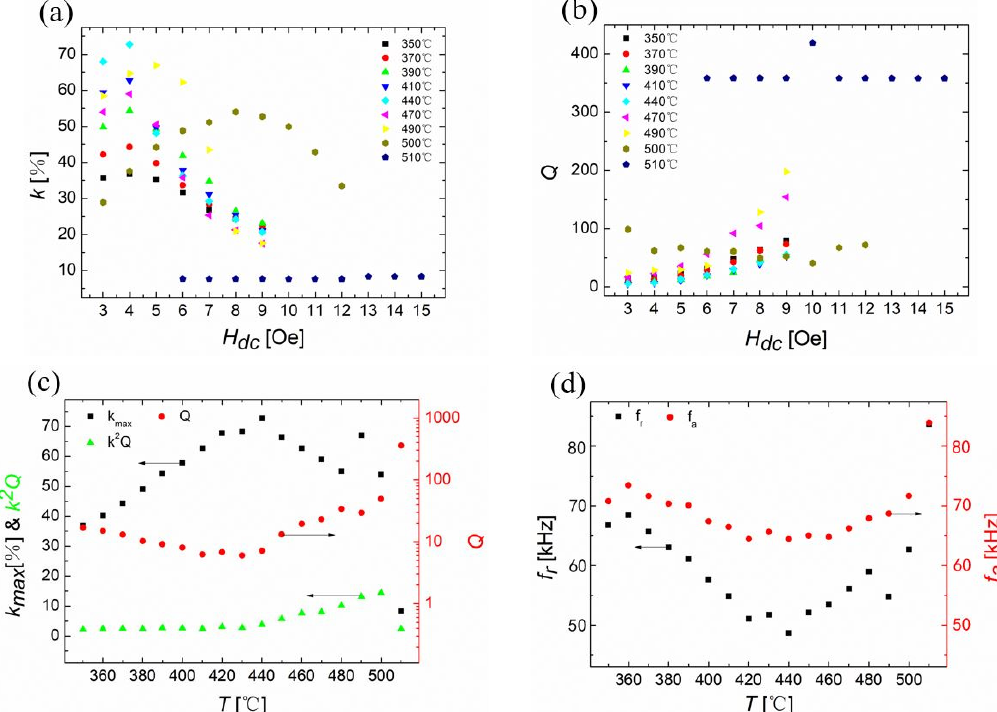
Figure 3. X-ray diffraction (XRD) patterns of Vitrovac ribbons on ( a ) shiny side and ( b ) dull side. The values of k in Metglas ribbons were plotted as a function of H dc , as shown in the required value of H dc for the annealed ribbon at 490 ◦ C was 5 Oe (or 398 A/m) or Figure 4a. Ribbons were annealed under 350 °C to 510 °C with an interval of 10 °C and even higher. The quality factors of Metglas ribbons under different annealing temperatures cooled down to the room temperature in air. The maximum values of k for the annealed are shown in Figure 4b. For the ribbon that was annealed at 440 ◦ C for 20 min, Q had a ribbon at 440 °C for 20 min was around 73% with an H dc of 4 Oe (or 318 A/m) along the minimum value of around 6 for an H dc of 3 Oe (or 239 A/m). longitudinal direction of the ribbon. However, the value of k decreased again when H dc kept increasing. Moreover, when the annealing temperature exceeded 440 °C, the maxi- mum value of k started to decrease. When the annealing temperature increased, the values of H dc that could maximize k also increased. For example, to achieve the maximum k val- ues, the annealed ribbons under 480 °C needed H dc values of 4 Oe (or 318 A/m). However, the required value of H dc for the annealed ribbon at 490 °C was 5 Oe (or 398 A/m) or even shown in Figure 4b. For the ribbon that was annealed at 440 °C for 20 min, Q had a mini- mum value of around 6 for an H dc of 3 Oe (or 239 A/m).